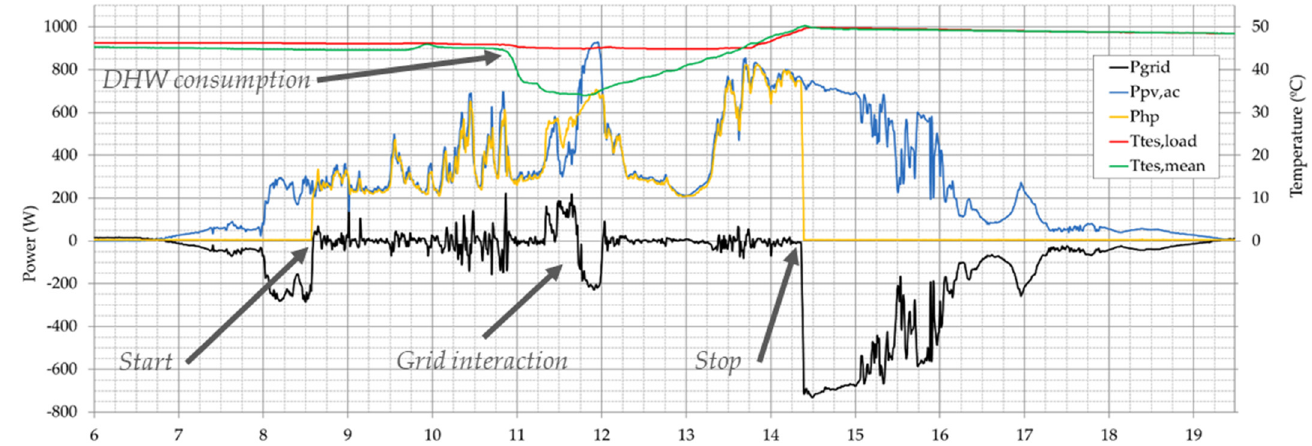
Figure 6. Main system electric power and TES state of charge profiles for the 15